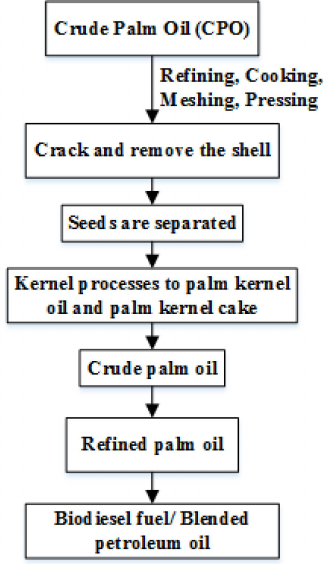
Figure 1. The process of palm oil-based biodiesel